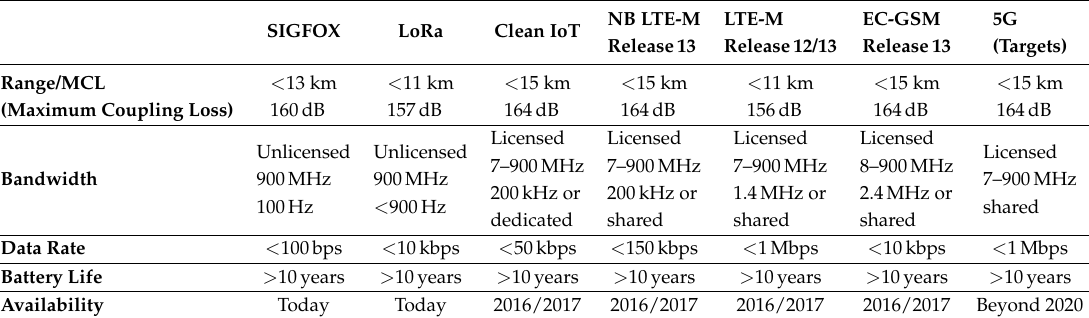
Table 1. Connectivity overview for M2M communications/M2M devices